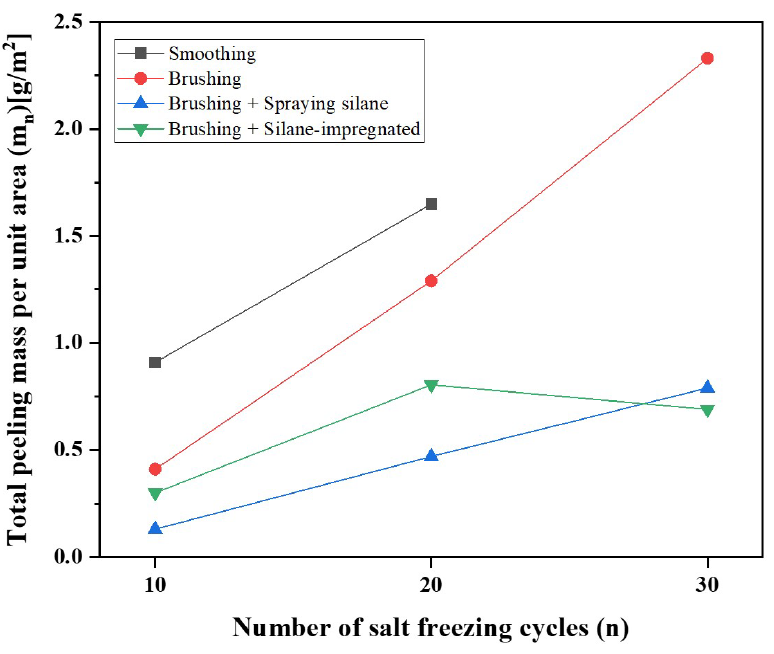
Figure 12. Total scaling mass per unit area in 10, 20, and 30 salt-freezing cycles.